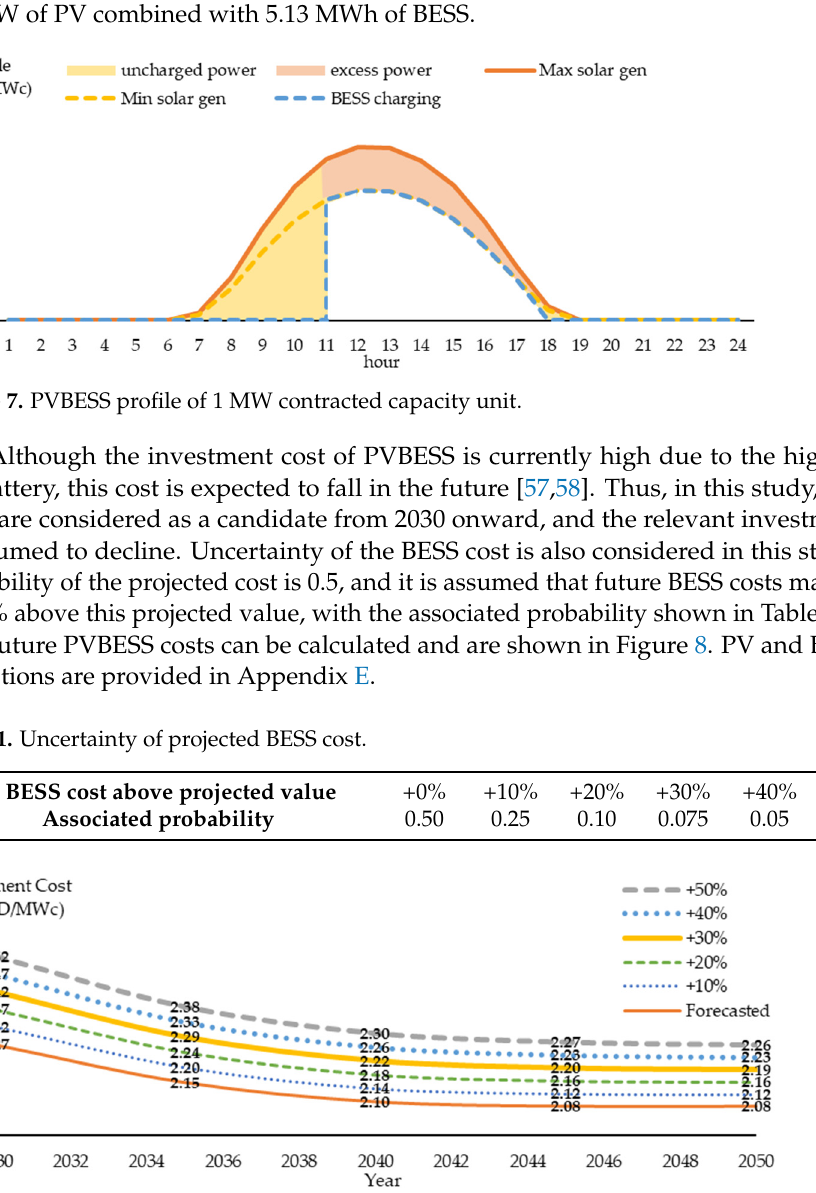
Figure 8. Investment cost of new PVBESS unit in each year with uncertainty. Table 1. Uncertainty of projected BESS cost.